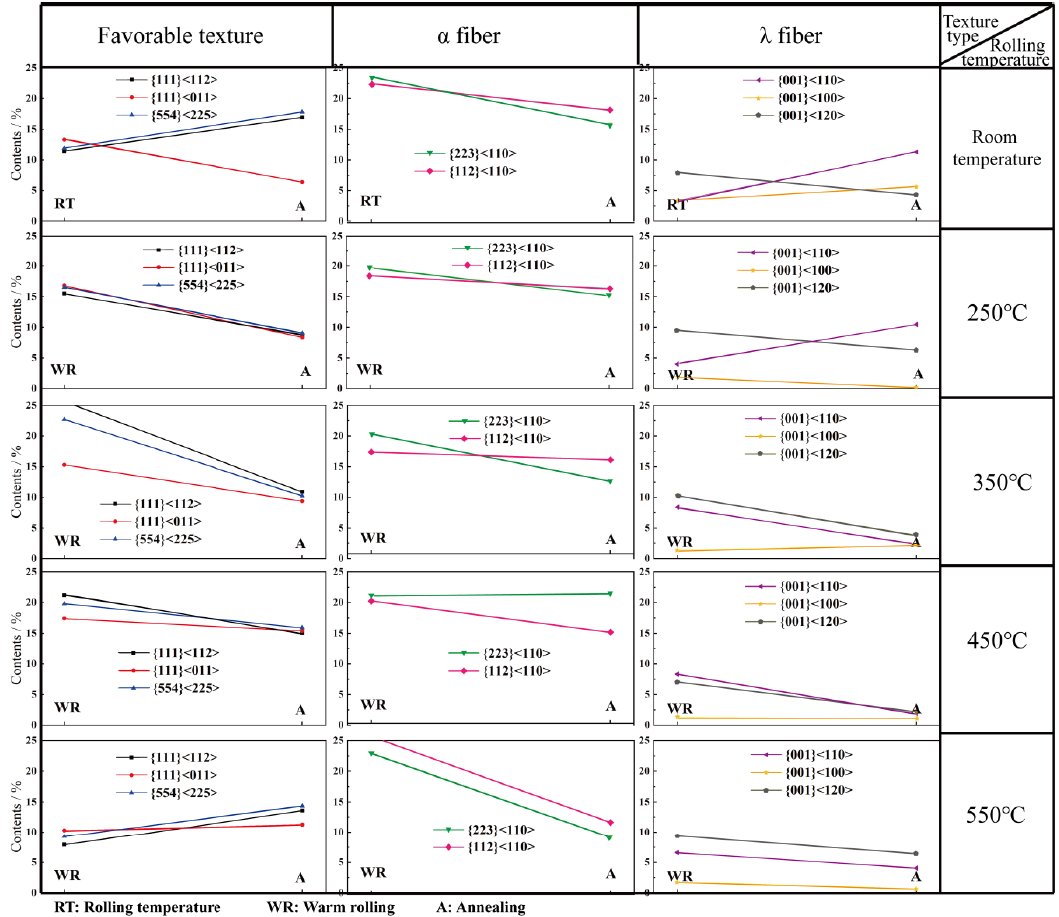
Figure 8. Several typical texture volume fractions of the warm-rolled and annealed sheets. Table 2. Texture factor of the warm-rolled and annealed sheets ( f γ -fiber / f ( α -fiber + λ -fiber ) ). Texture Factor / Temperature